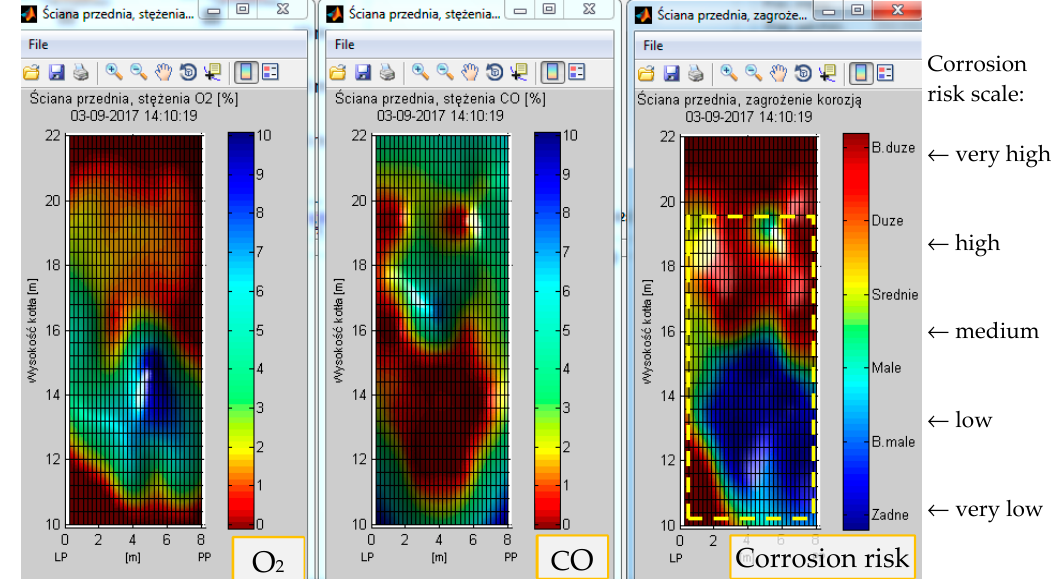
Figure 12. The maps of O 2 , CO concentration, and corrosion risk, generated by Rachel software from half year OP-230 boiler operation data [38]. The scale of the corrosion risk in this figure is the same as in Table 2—from none (blue color) up to very high (red color).